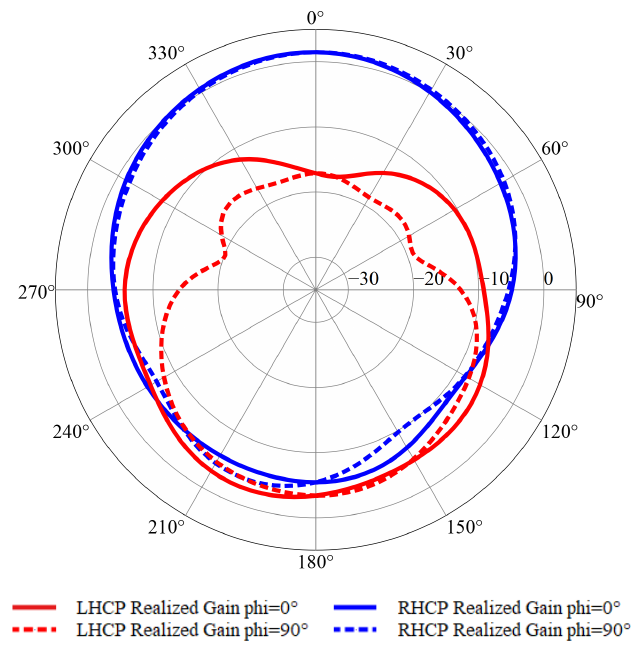
Figure 11. Measured LHCP and RHCP Gain versus theta for phi = 0 ◦ and 90 ◦ .